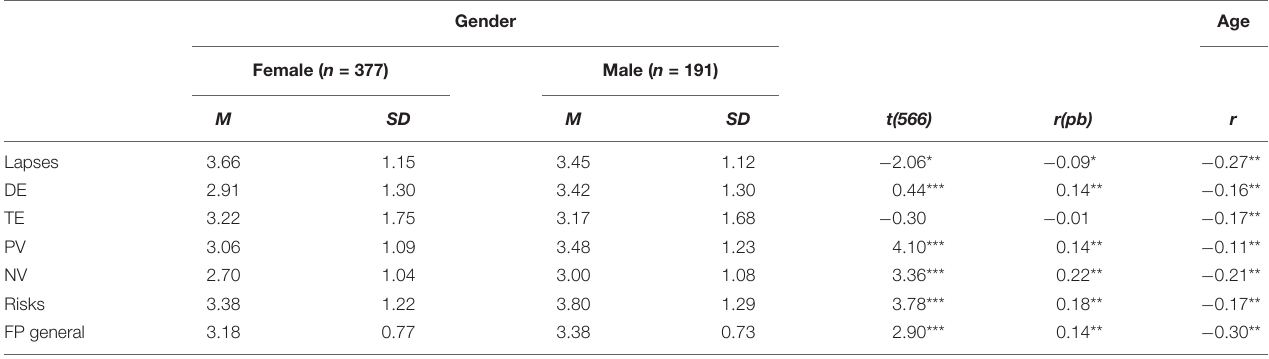
TABLE 2 | Means and standard deviations of the FP scores for men and women and their correlation with age. Gender Age Female ( n = 377) Male ( n =